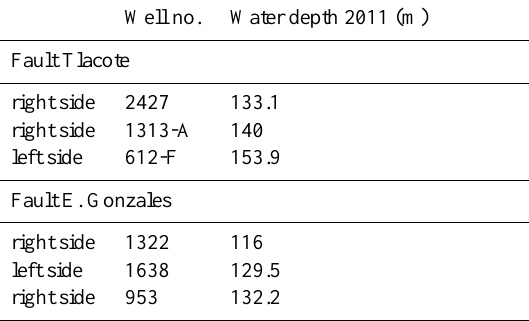
Table 1. Water depths of some wells in Queretaro in